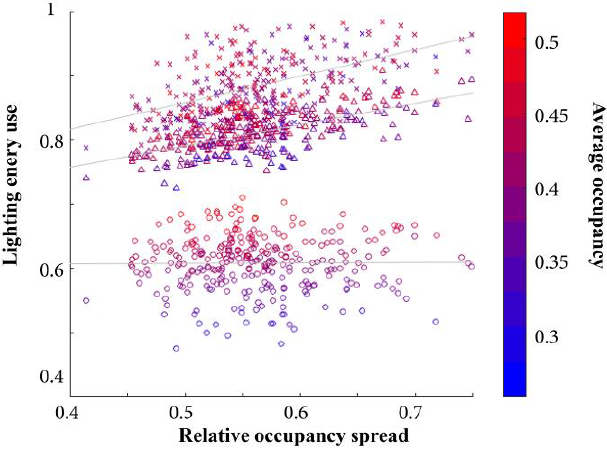
Figure 7. Average occupancy versus lighting energy use and relative occupancy spread for room control (crosses), subgroup control (triangles), and individual control (circles).